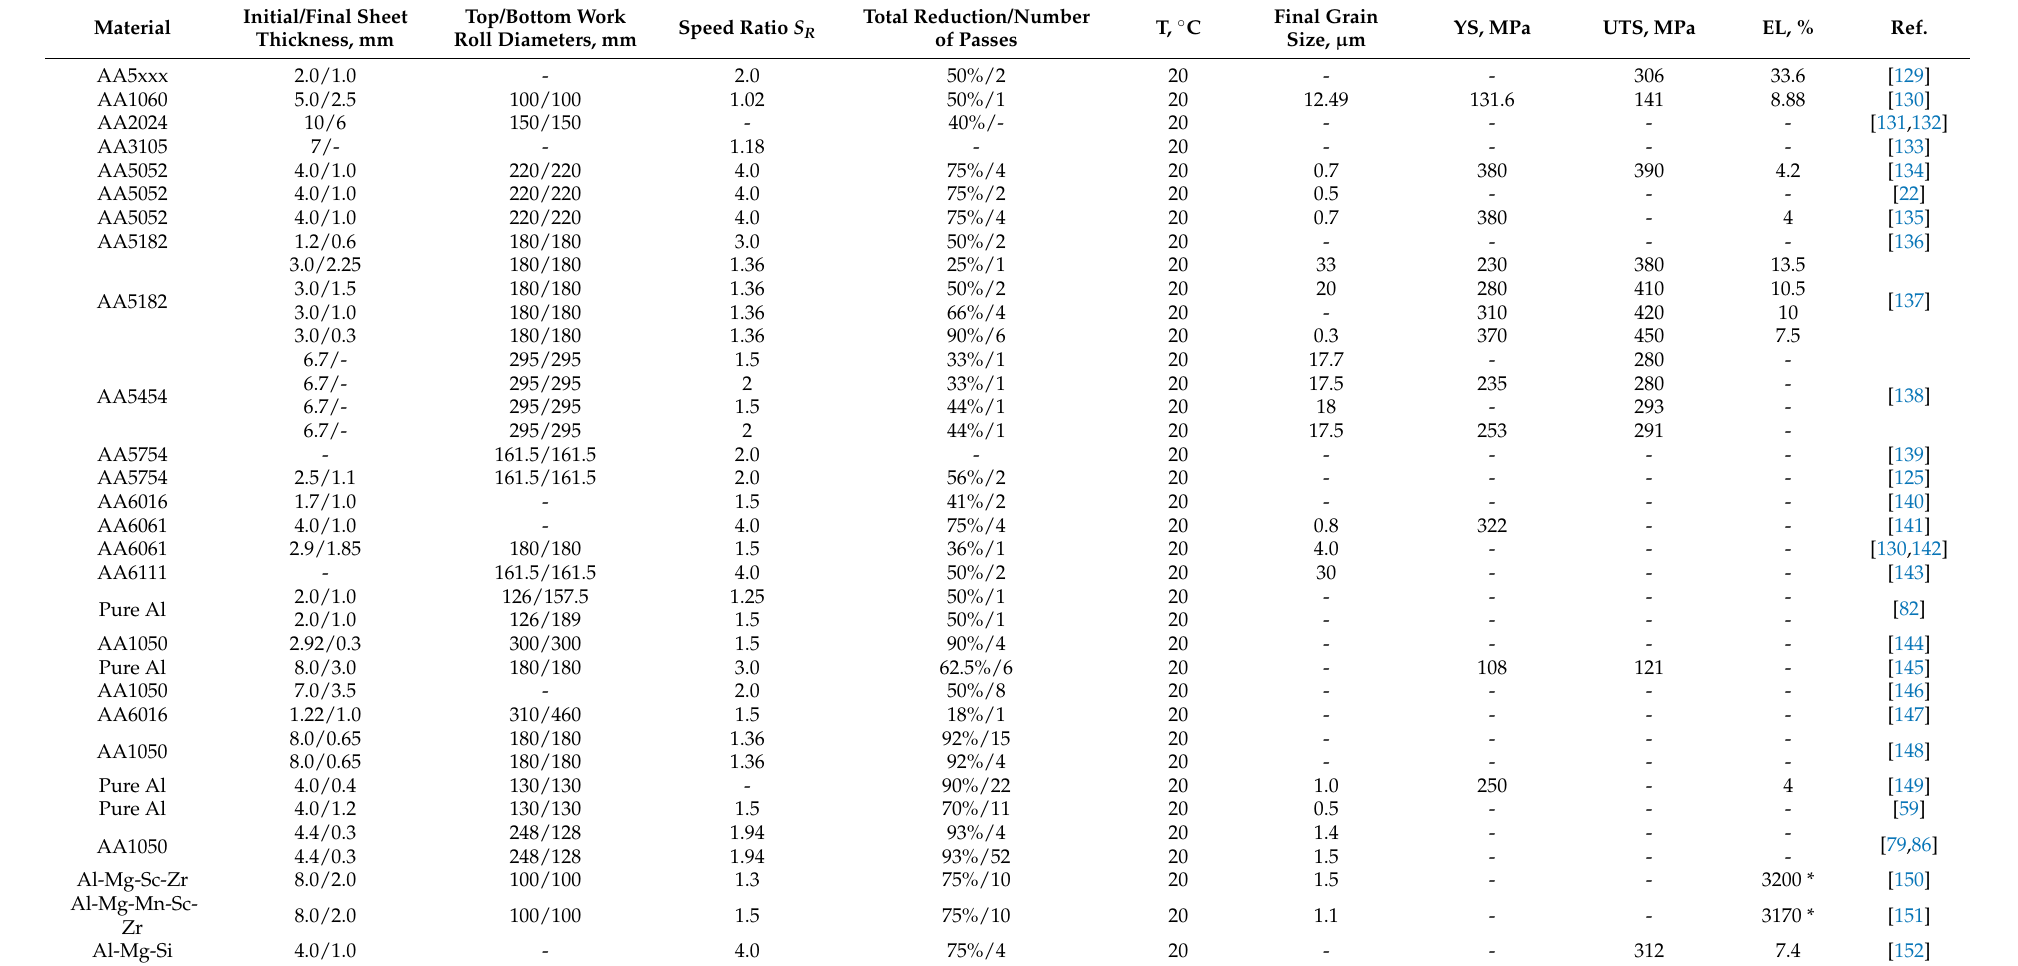
Table 7. Experimental data related to asymmetric cold rolling of Al